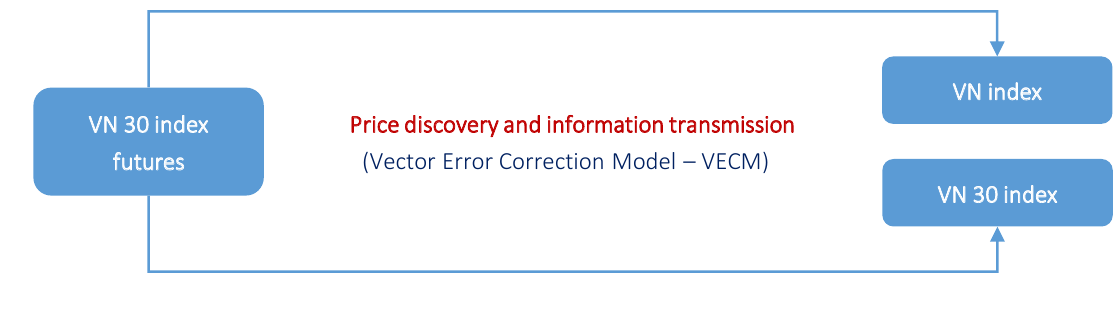
Figure 1. Research